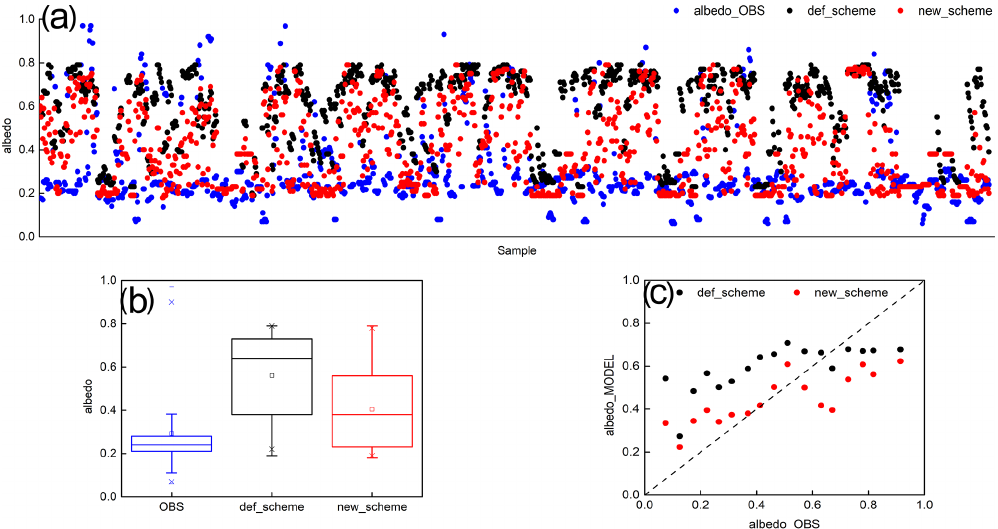
Figure 4. Scatterplot of albedo from observations and model estimates for the eight experiments ( a : horizontal axis denotes samples from EXP1 to EXP8), corresponding box-and-whisker plot (b) with lower and upper boundaries of the box indicating the first and third quartiles of albedo, respectively, and the line inside the box indicating the median of albedo and averaged albedo observations every 0.05 segments (i.e., 0–0.049, 0.05–0.099, 0.1–0.149, 0.15–0.199,...,0.85–0.899, 0.9–0.949, 0.95–0.999) and model estimates at the same time as observations for all experiments (c) . For def_scheme and new_scheme, see Fig. 2.